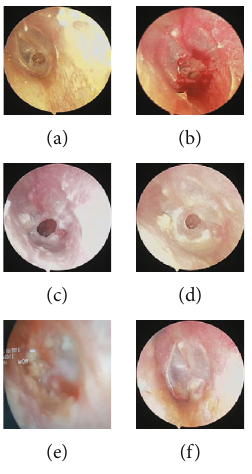
Figure 4: (Patient 9): a 55-year-old man with a left traumatic medium-sized perforation. The perforation at 3 years before treatment (a), freshened edges (b), and the perforation at 3 days (c) and 1 (d), 2 (e), and 8 (f) weeks after starting